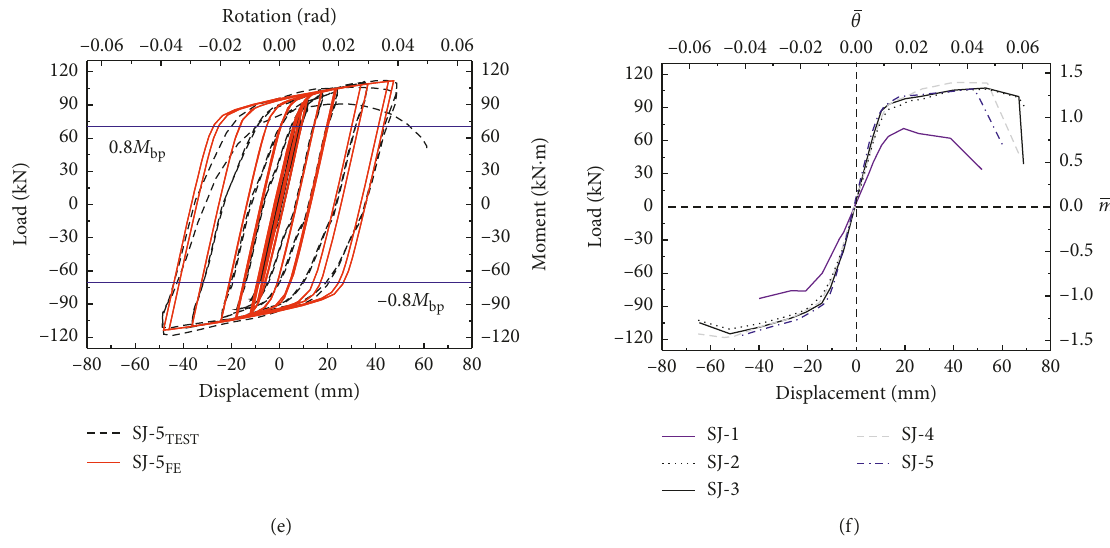
Figure 10: Hysterical and skeleton curves. (a) SJ-1. (b) SJ-2. (c) SJ-3. (d) SJ-4. (e) SJ-5. (f) Skeleton